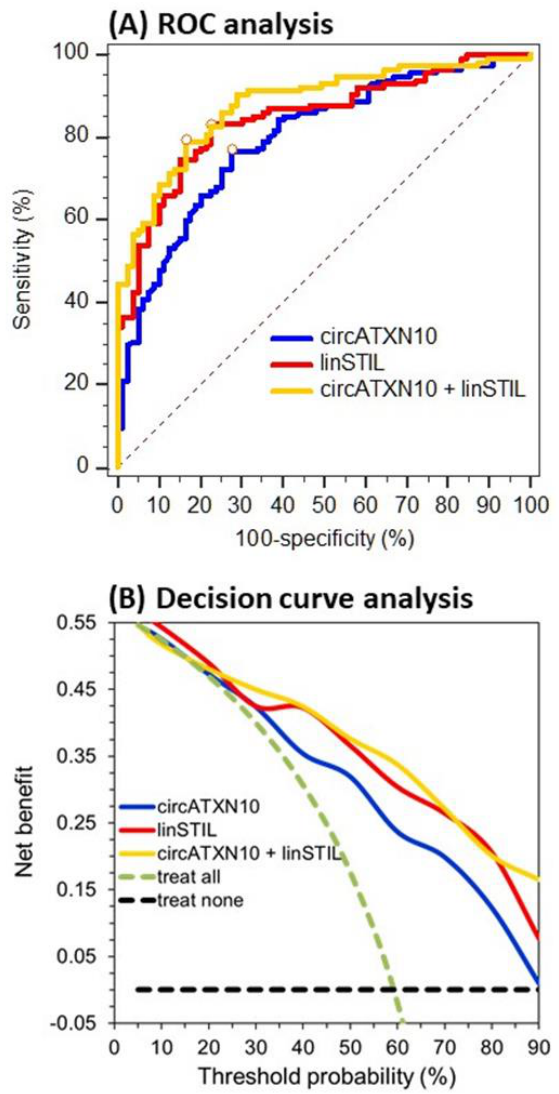
Figure 5. Receiver operating characteristic (ROC) curve and decision curve analyses of circ ATXN10 and lin STIL as individual markers and in combination for discrimination between adjacent normal and malignant tissue samples. The data reflect the results shown in Table 5 for circ ATXN10 , lin STIL , and their combination.